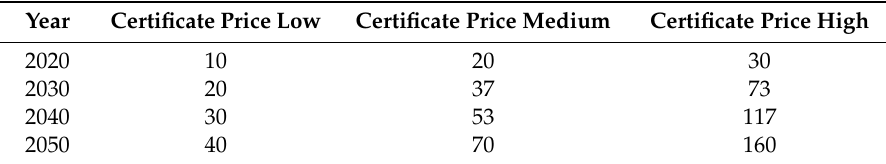
Table 5. CO 2 certificate price development paths according to [36,37] assumed for sensitivity cases (unit: €/tCO 2 ).